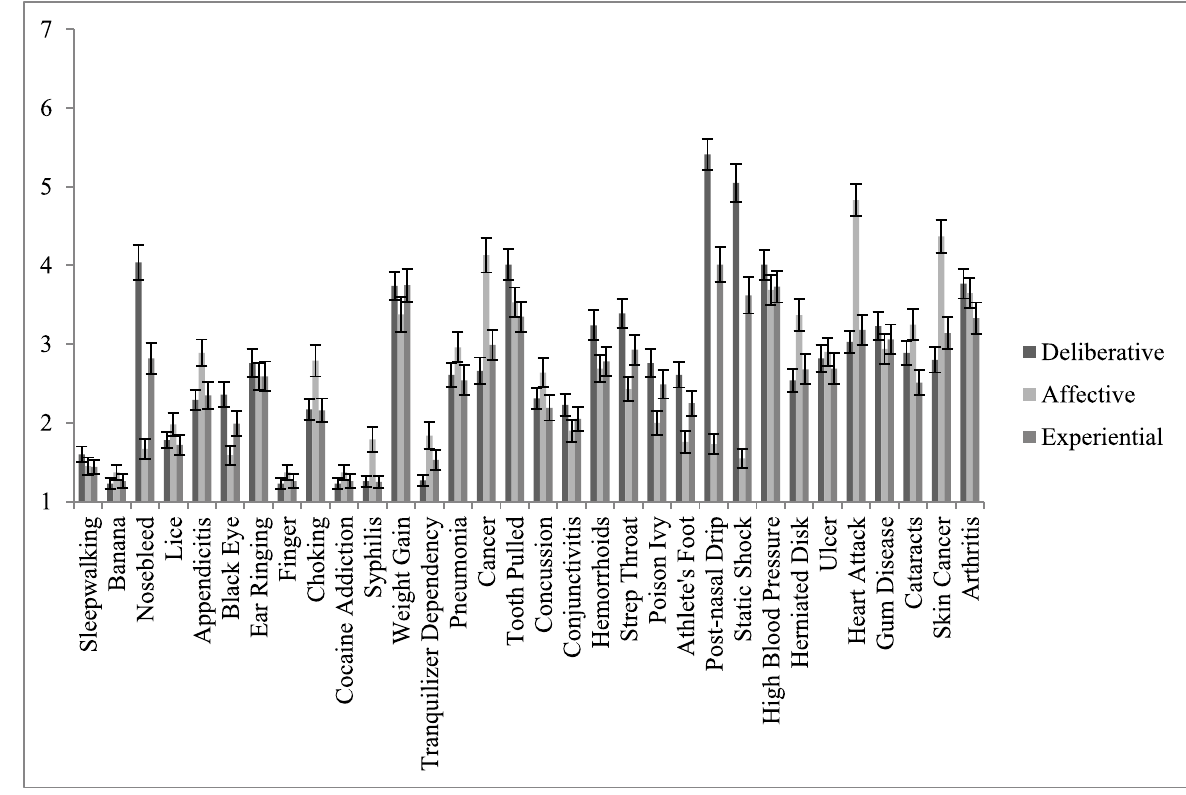
Fig 1. Distributions of TRIRISK components by